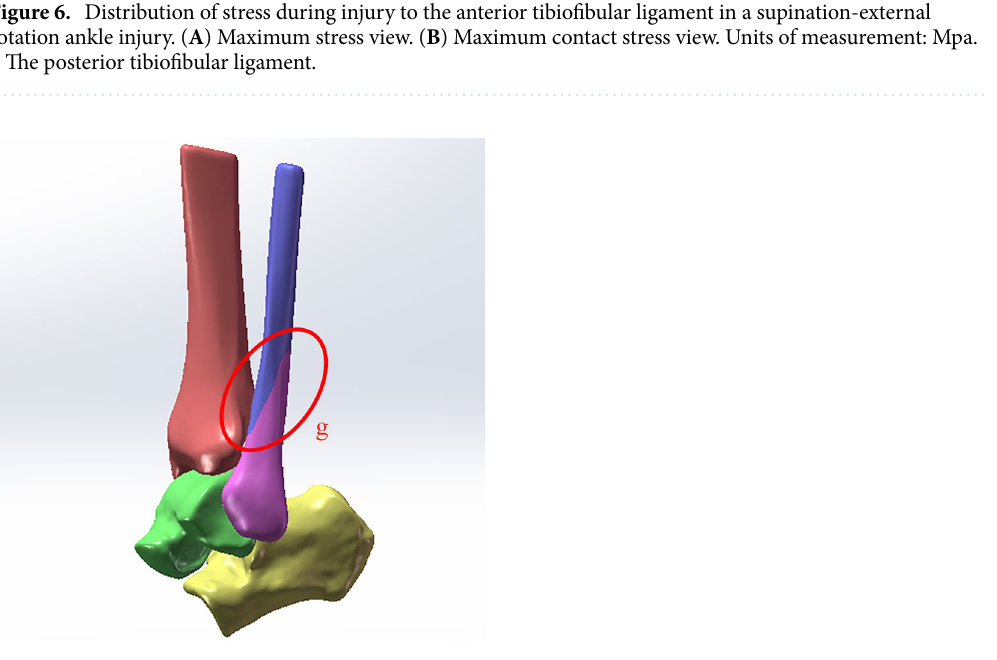
Figure 7. Model of lateral malleolar fracture in a supination-external rotation ankle joint injury. g: The fracture